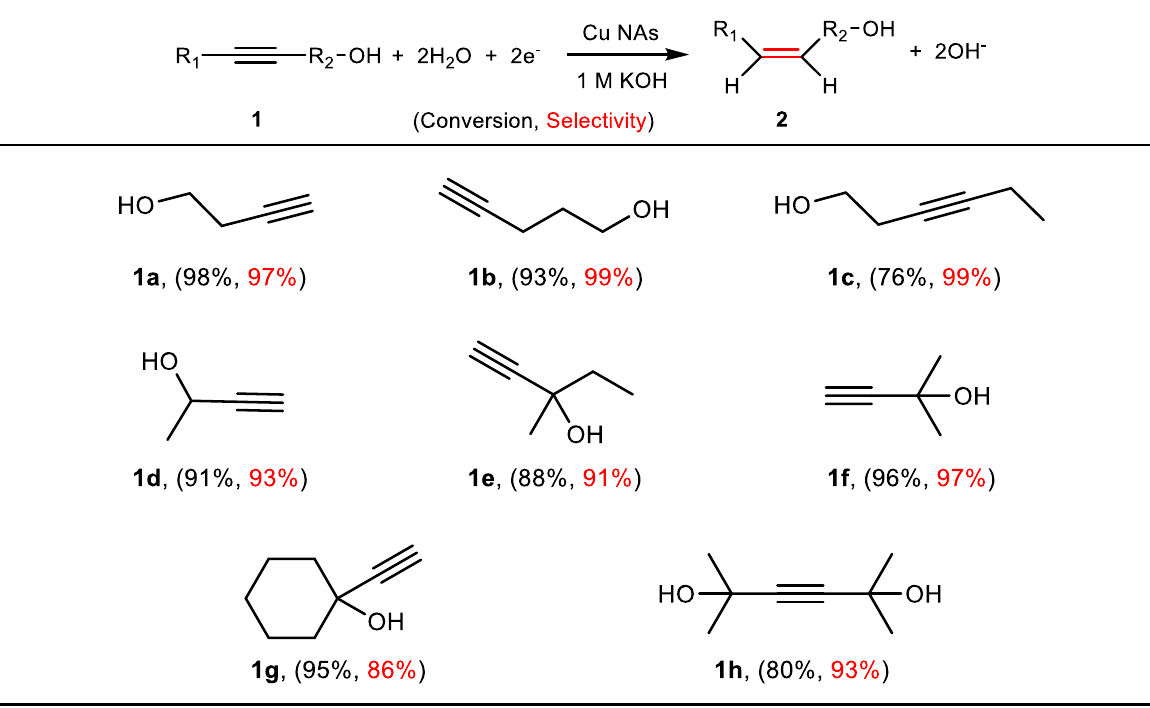
Alkynols were electrochemically hydrogenated at a current density of 1.3 A cm –2 and a time of 15 minutes, except for 1c and 1h , which were hydrogenated for 30 and 60 minutes, respectively. Reaction conditions: 20 mL of 1